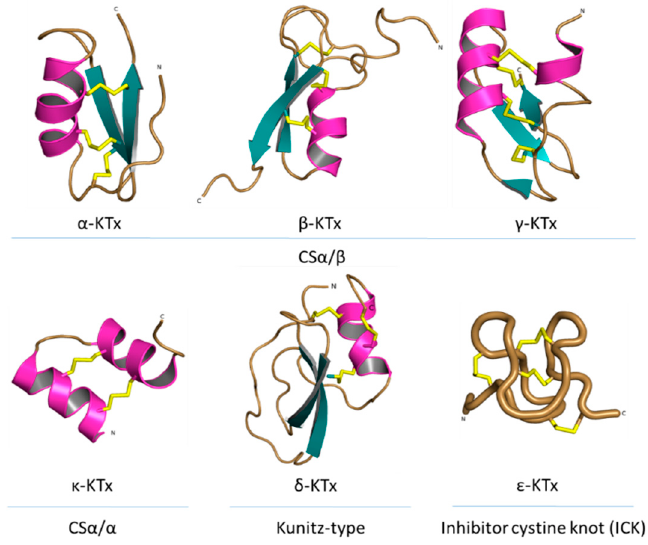
Figure 7. Structural folds present in the KTx families. α -KTx: MgTx (1MTX), β -KTx: HgeScplp1 (5IPO), γ -KTx: Ergtoxin (1PX9), κ -KTx: OmTx2 (1WQC), δ -KTx: LmKTT-1a (2M01) and ε -KTx: Ts11 (2MSF). PDB entries are shown in parentheses.